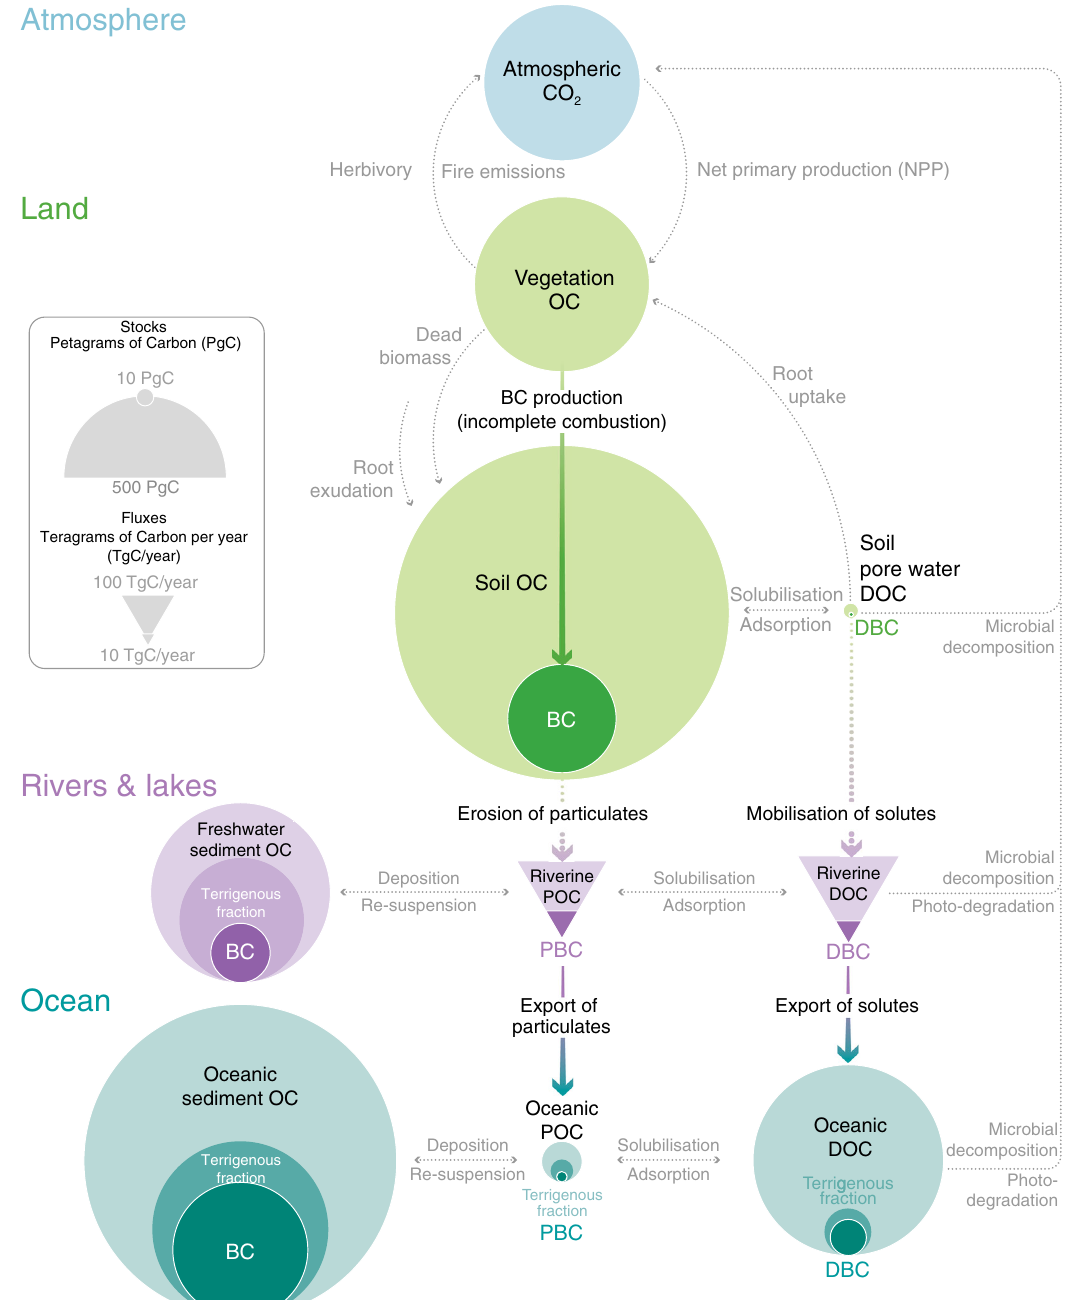
Fig. 1 Global dynamics of black carbon (BC) and organic carbon (OC). DOC dissolved organic carbon, DBC dissolved black carbon, POC particulate organic carbon, PBC particulate black carbon. The relative size of the stocks and fl uxes of OC and BC in soils, sediments, dissolved organic matter and suspended particulates are indicated by the size of the circles (stocks) and triangles ( fl uxes). BC is selectively preserved across the land-to-ocean aquatic continuum and thus represents a large fraction of the terrigenous OC in ocean pools. Rivers are the primary source of oceanic BC, though small additional fl uxes of aerosol BC (soot) to the ocean surface are not shown. The estimates for each stock and fl ux are provided in Supplementary Dataset along with references to source